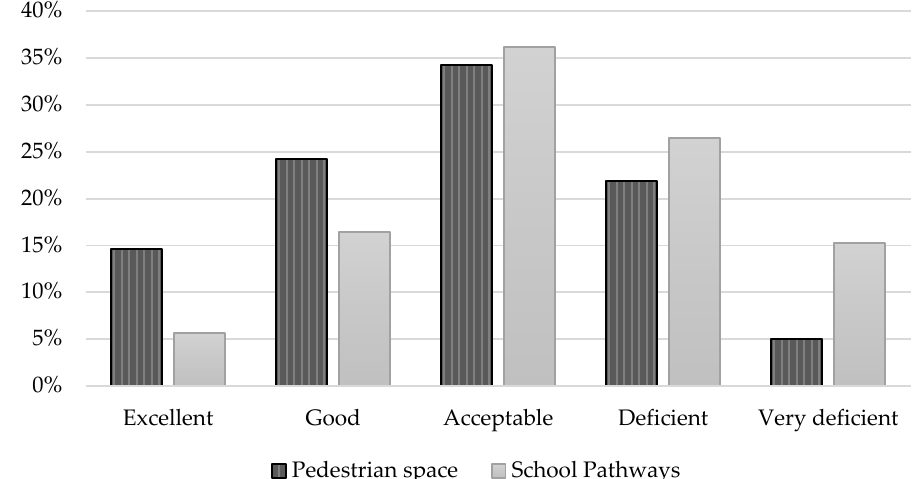
Figure 11. Pedestrian space assessment.